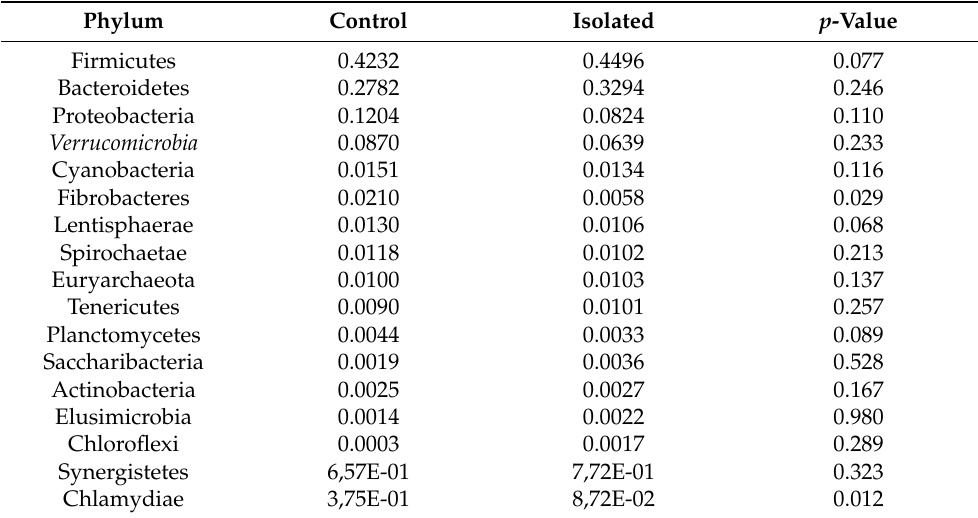
Table 1. Composition at phylum level of the sheep hindgut microbiome in the two husbandry conditions (control and isolated) and the p -value of their relative difference (relative abundances).